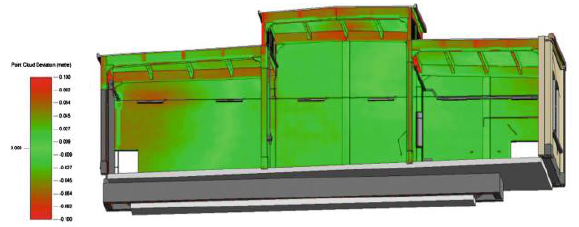
Figure 11. Discrepancy between the point cloud and parametric model. (most of the points that belong to the surface of the walls have a deviation that does not exceed 3 cm).